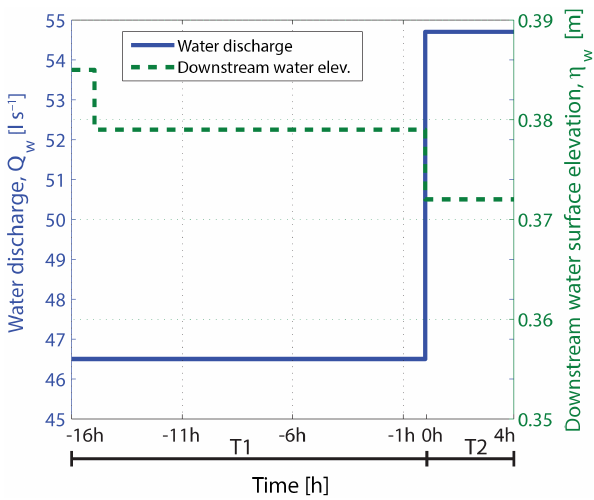
Figure 2. Water discharge, Q w , and base level (i.e., water surface elevation at the downstream end), η w , imposed in Experiments T 1 and T 2 . The water surface elevation was measured at x = 10 .